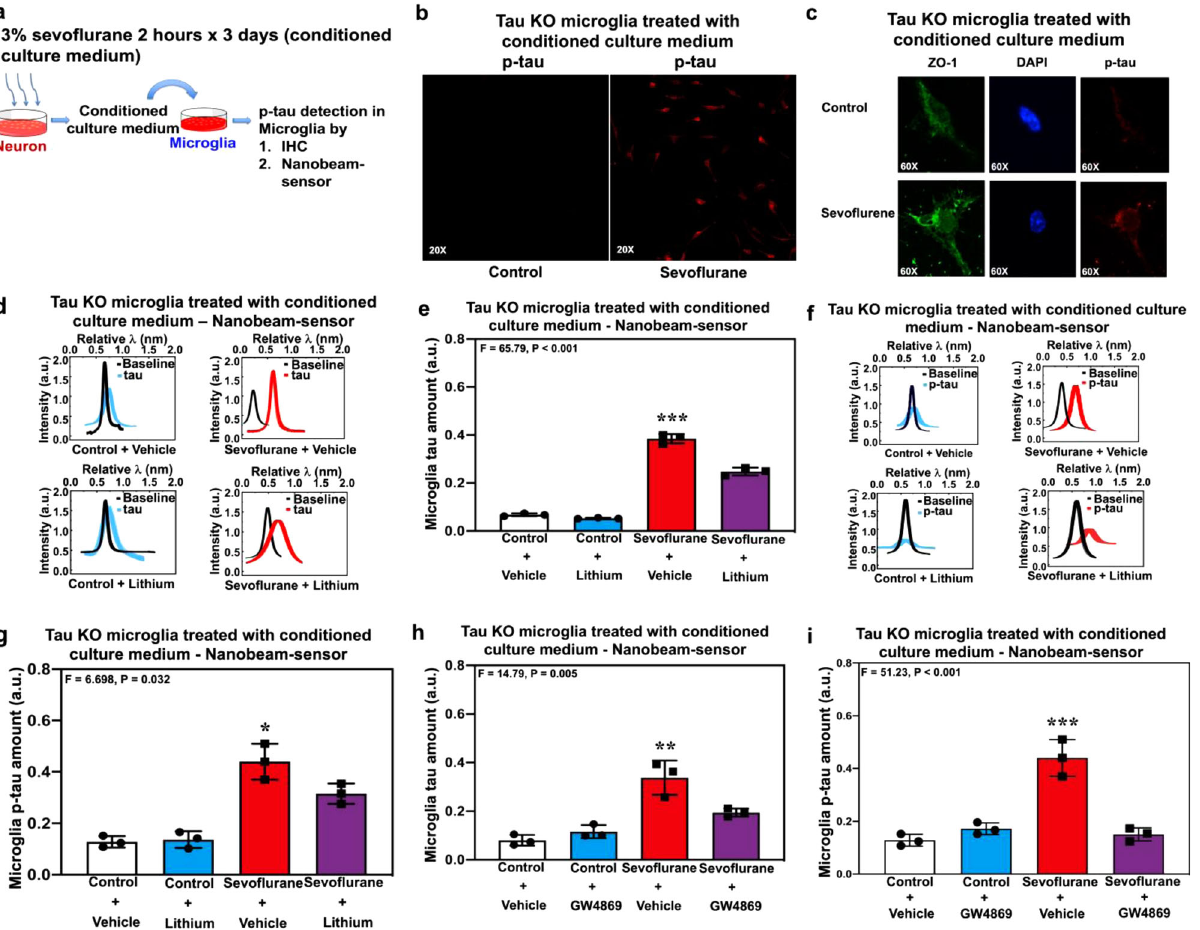
Fig. 5 Sevo fl urane-conditioned neuron culture medium caused the appearance of tau and p-tau in tau KO microglia. a Experimental design. b Immunohistochemistry showing the appearance of p-tau in a group of tau KO microglia following the treatment of sevo fl urane-conditioned neuron culture medium. c Immunohistochemistry showing the appearance of p-tau in a single tau KO microglia following the treatment of sevo fl urane-conditioned neuron culture medium. d Nanobeam-sensor spectrum data representing tau in the lysates of tau KO microglia following the treatment of sevo fl urane- conditioned neuron culture medium with and without lithium. e Quanti fi cation of nanobeam-sensor measurement of tau. f Nanobeam-sensor spectrum data representing p-tau in the lysates of tau KO microglia following the treatment of sevo fl urane-conditioned neuron culture medium with and without lithium. g Quanti fi cation of nanobeam-sensor measurement of p-tau. h Nanobeam-sensor measurement of tau in the lysates of tau KO microglia following the treatment of sevo fl urane-conditioned neuron culture medium with and without GW4869. i Nanobeam-sensor measurement of p-tau in the lysates of tau KO microglia following the treatment of sevo fl urane-conditioned neuron culture medium with and without GW4869. N = 3 biologically independent samples in each group. Two-way ANOVA and post-hoc analysis with Bonferroni were used to analyze the data presented in Fig. 5e, g, h, i. The P values of two-way ANOVA refer to the interaction of group (control condition versus sevo fl urane) and treatment (vehicle versus lithium or GW4869) on the amounts of tau or p-tau. The P values of the post-hoc analysis with Bonferroni refer to the difference on the amounts of tau or p-tau between the control condition and sevo fl urane. * P < 0.05, ** P < 0.01, *** P < 0.001. Error bar indicates standard deviation. P-tau phosphorylated tau, KO fi ndings that lithium, the inhibitor of tau phosphorylation, atte- nuated the sevo fl urane-induced increases in both tau and p-tau in neuron culture medium, EVs and microglia demonstrated that such increases were dependent, at least partially, on tau phosphorylation.